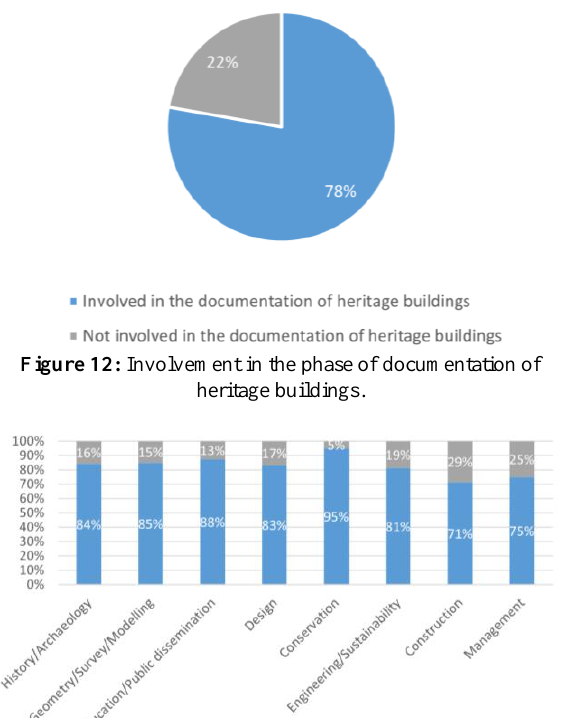
Figure 10: Percentage of BIM projects that need future re- accessibility.